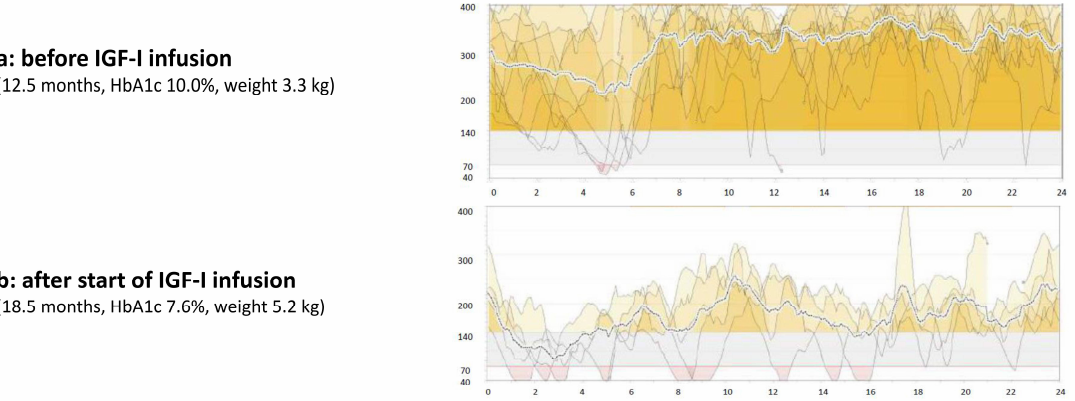
Figure 2. Glucose profile using a continuous glucose monitoring system (CGMS) before ( a ) and after ( b ) initiation of continuous subcutaneous mecasermin infusion via an insulin pump.